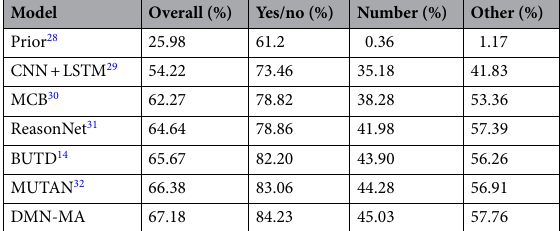
Table 3. Results of DMN-MA model in VQA2.0 test-standard split.